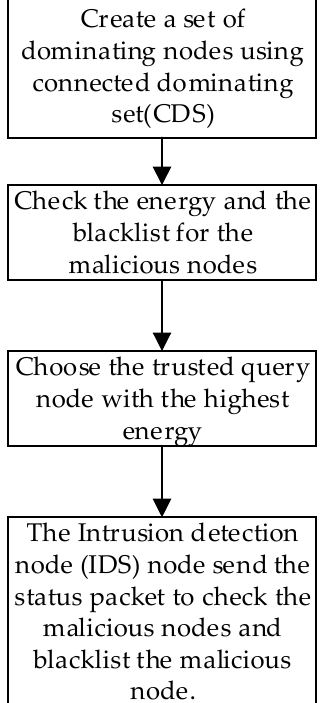
Figure 2. The selection of the query issuing node and the detection method.